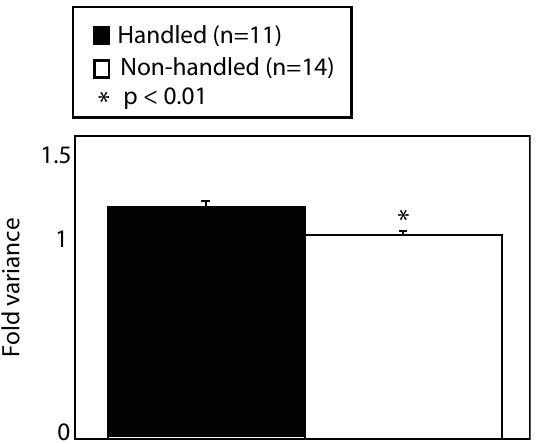
Figure 2. Variance of log-transformed gene expression levels in the CA1 of the hippocampus is affected by postnatal handling. Postnatal handling resulted in an increased variance of log-transformed gene expression levels in the same direction and magnitude as in high activity mice. Changes in gene expression organization were accompanied by increased activity in the open field (supplemental figure S2) and increased activity in the light compart- ment in the light-dark paradigm (supplemental figure S3).